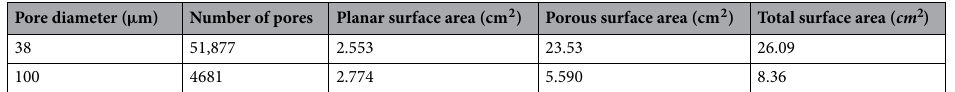
Pore diameter ( µ